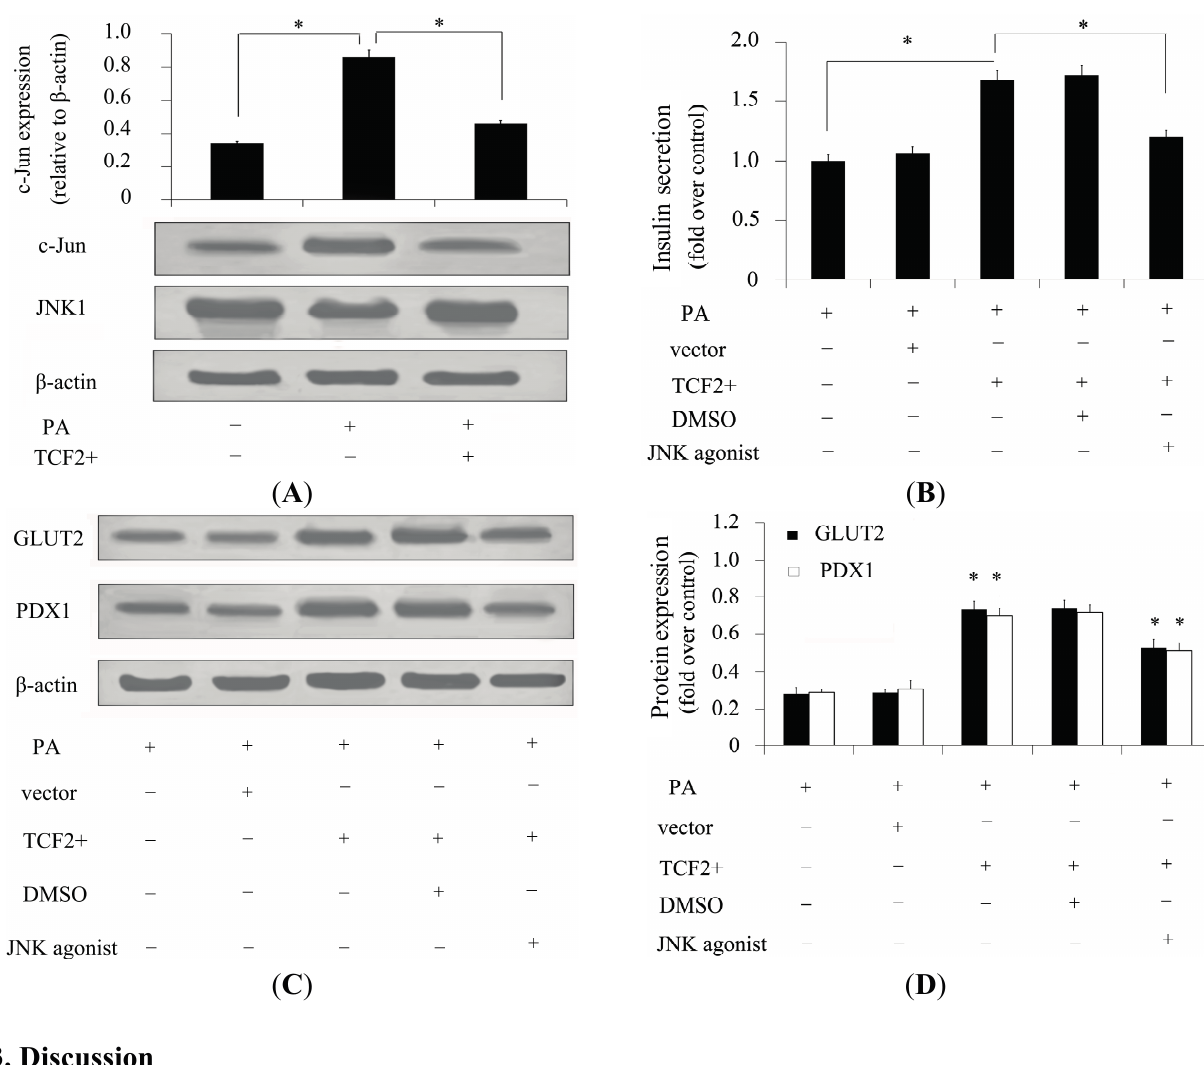
Figure 5. Inhibition of TCF2 decreases insulin secretion via the JNK signaling pathway. INS-1 cells were cultured in DMEM containing 25 mM glucose and pretreated with 800 μ M PA to investigate the effect of FFAs on INS-1 gene expression. Activation of JNK signaling was detected by Western blotting ( A ) in INS-1 cells overexpressing TCF2 or not that were cultured in DMEM containing 25 mM glucose (control) or PA (800 μ M). JNK signaling was also detected in INS-1 cells overexpressing TCF2 cultured in DMEM containing 25 mM glucose and PA (800 μ M) ( A ); GSIS was analyzed with DMSO or JNK agonist to confirm the positive regulatory effect of TCF2 on GSIS through negative regulation of JNK signaling ( B ); In addition, expression of GLUT2 and PDX1 was evaluated by Western blotting ( C ) and quantified ( D ) to evaluate the effect of JNK agonist on gene expression related to insulin secretion. * p <